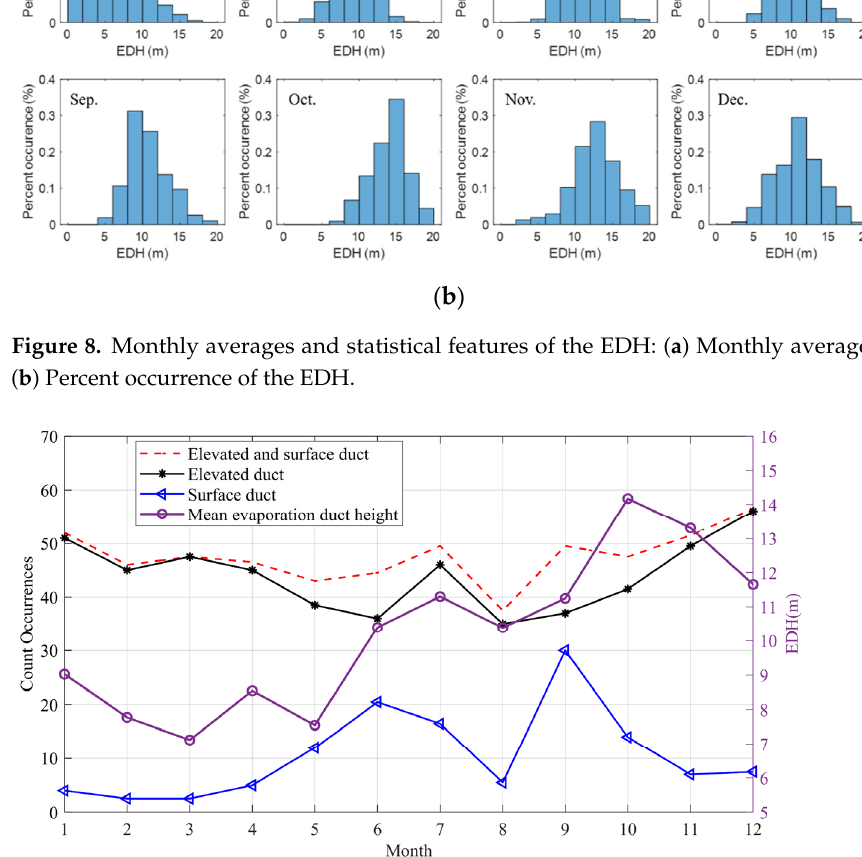
Figure 8. Monthly averages and statistical features of the EDH: ( a ) Monthly average of the EDH. ( b ) Percent occurrence of the EDH.